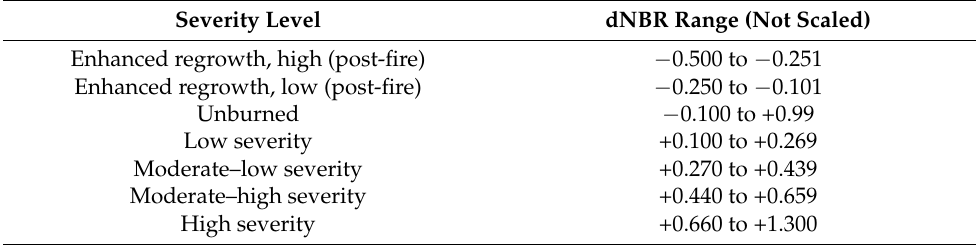
Table 4. RBR range for classification as suggested by USGS. Adapted from